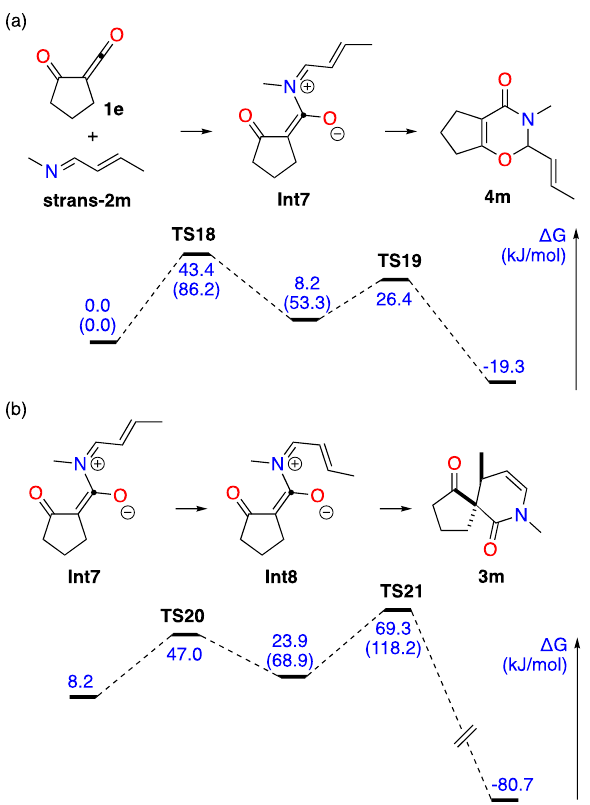
Figure 4. Free Gibbs energy profiles computed at 298 K (DFT, B3LYP-D3 / 6-311 ++ G(d,p)) of the aza-Diels − Alder reactions between the α -oxoketene 1e and the 1-azadiene 2m . Free Gibbs energies noted between parentheses were computed at 413 K.